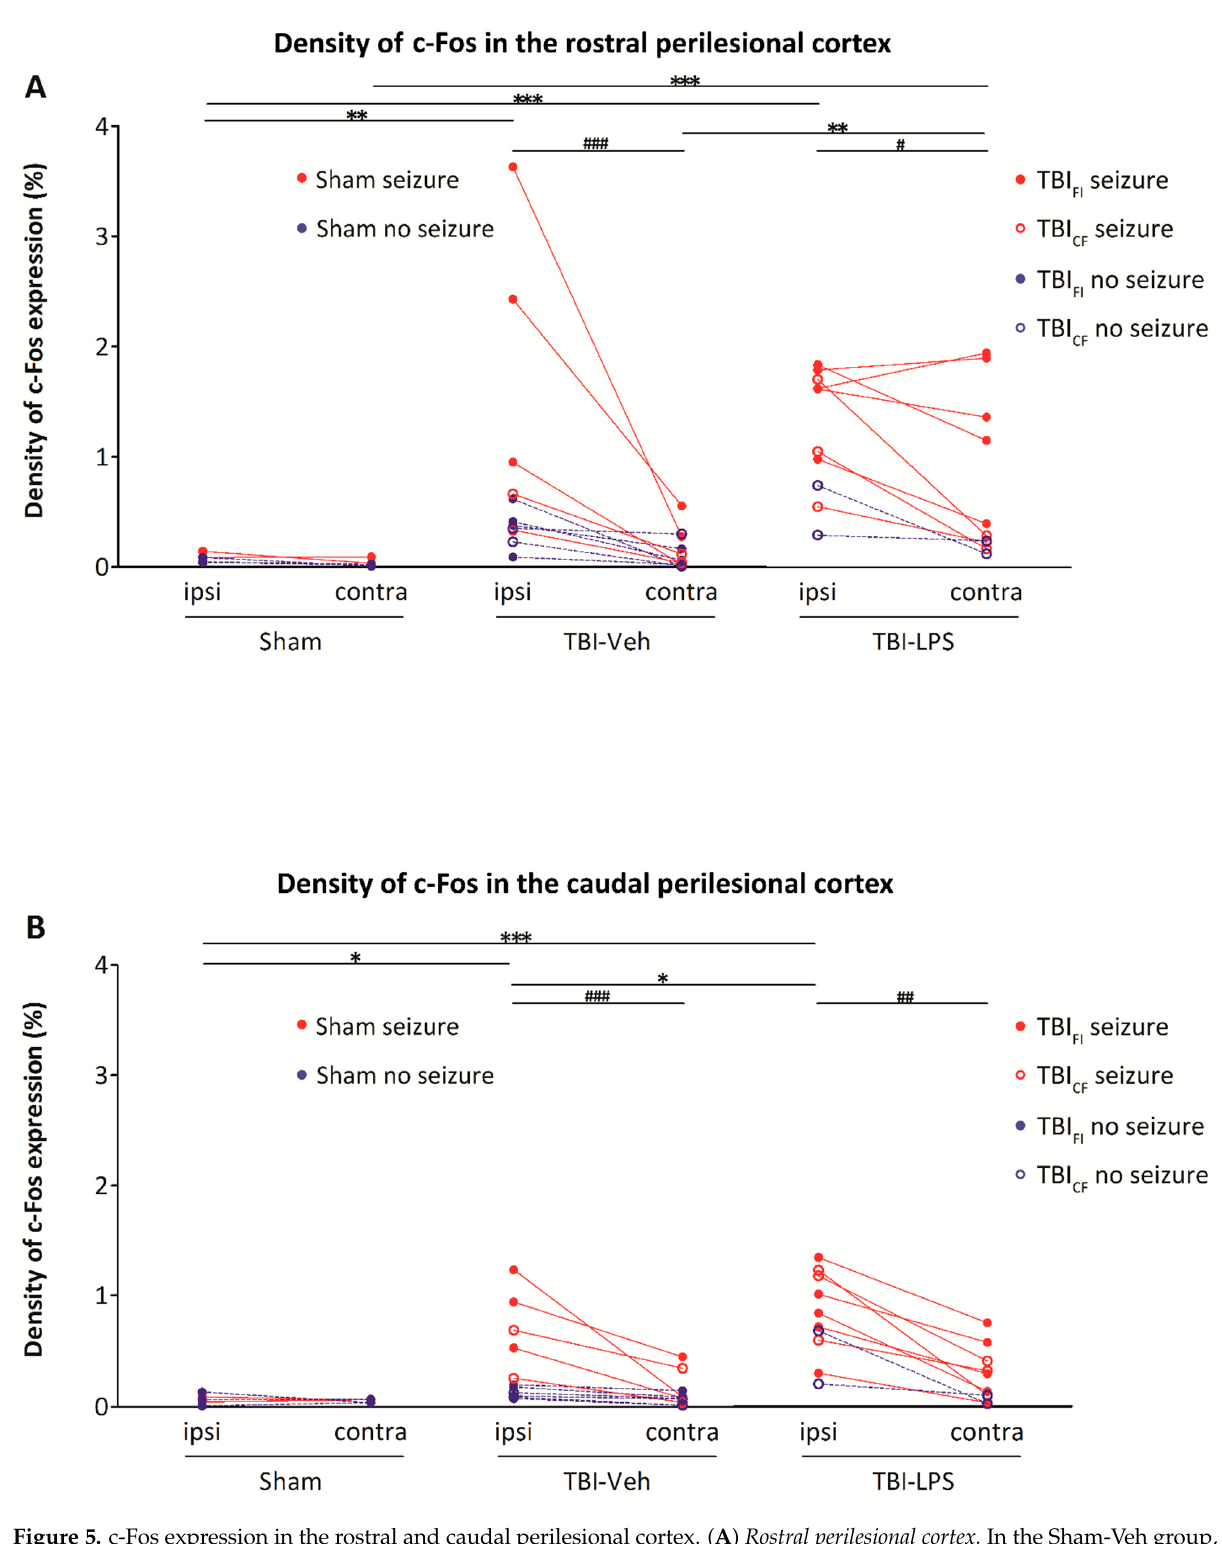
Figure 5. c-Fos expression in the rostral and caudal perilesional cortex. ( A ) Rostral perilesional cortex. In the Sham-Veh group, the density of c-Fos expression was comparable between the ipsilateral and contralateral perilesional cortex rostrally. In the TBI-Veh group, c-Fos expression was increased ipsilaterally compared with the Sham-Veh group. In the TBI-LPS group, the density of c-Fos expression was higher both ipsilaterally and contralaterally than in the Sham-Veh group. Contralateral labeling was also higher than that in the TBI-Veh group. Inter-hemispheric analysis showed higher c-Fos labeling ipsilaterally than contralaterally in both the TBI-Veh and TBI-LPS groups. ( B ) Caudal perilesional cortex . In the Sham-Veh group, the density of c-Fos expression was comparable between the ipsilateral and contralateral perilesional